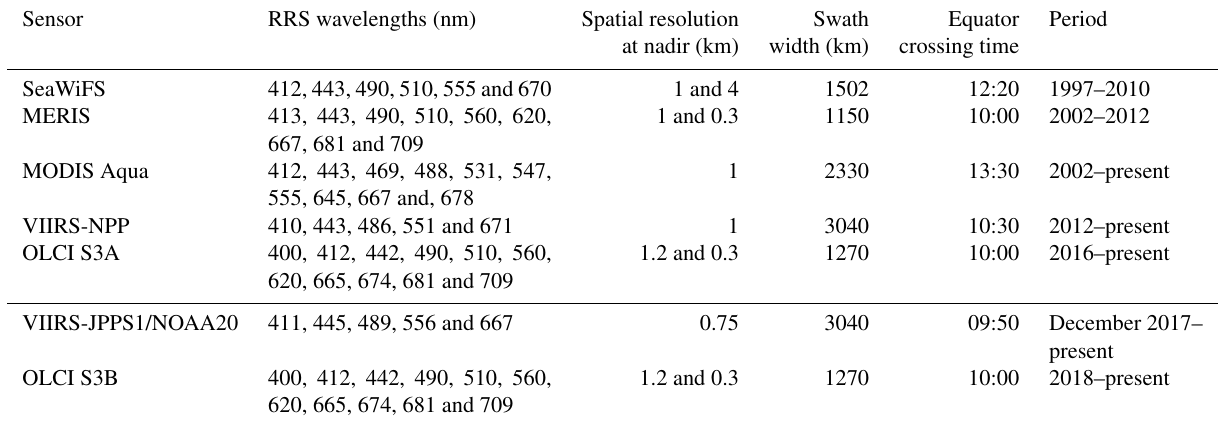
Table 1. Main characteristics of sensors/bands used for CMEMS (VIIRS-JPPS1 and OLCI-S3B will be used by the GlobColour processor in the framework of the CMEMS release scheduled in July 2019).